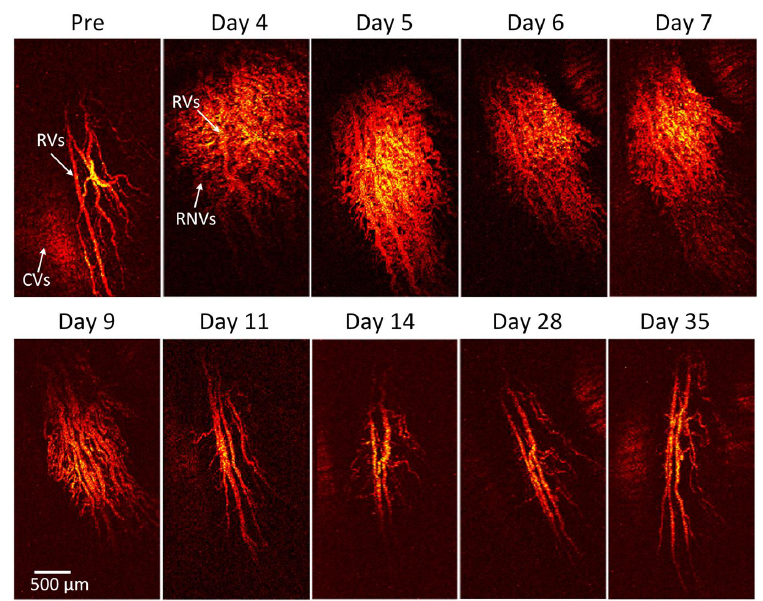
Figure 4. In vivo optical resolution (OR-PAM) images of retinal neovascularization. Maximum intensity projection (MIP) PAM images of the rabbit retinal vessels were acquired before and after retinal neovascularizarion (RNV) model at various times. The MIP OR-PAM images show clearly the structure of individual retinal blood vessels including choroidal vessels (CVs), retinal vessels (RVs), RNV and capillaries. J. Imaging 2018 , 4 , x FOR PEER REVIEW